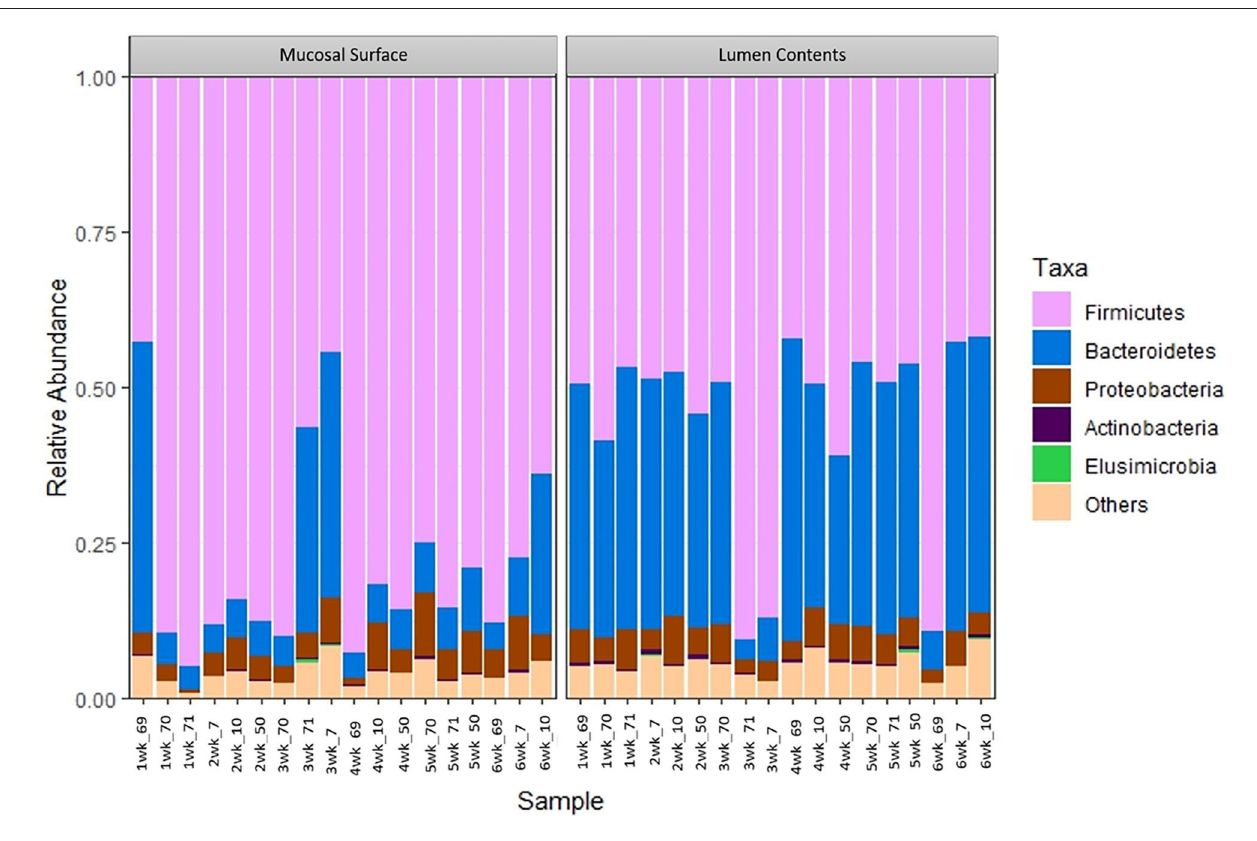
FIGURE 4 | Bacterial phylum. Stacked bar chart representing the abundance of the top five phyla microbiota in the mucosal biopsy surface and lumen contents across the sampled weeks for each